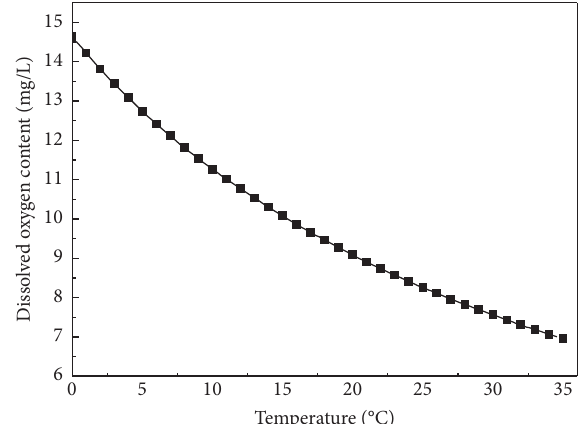
Figure 5: The comparison of temperature and saturated dissolved oxygen (atmospheric pressure,